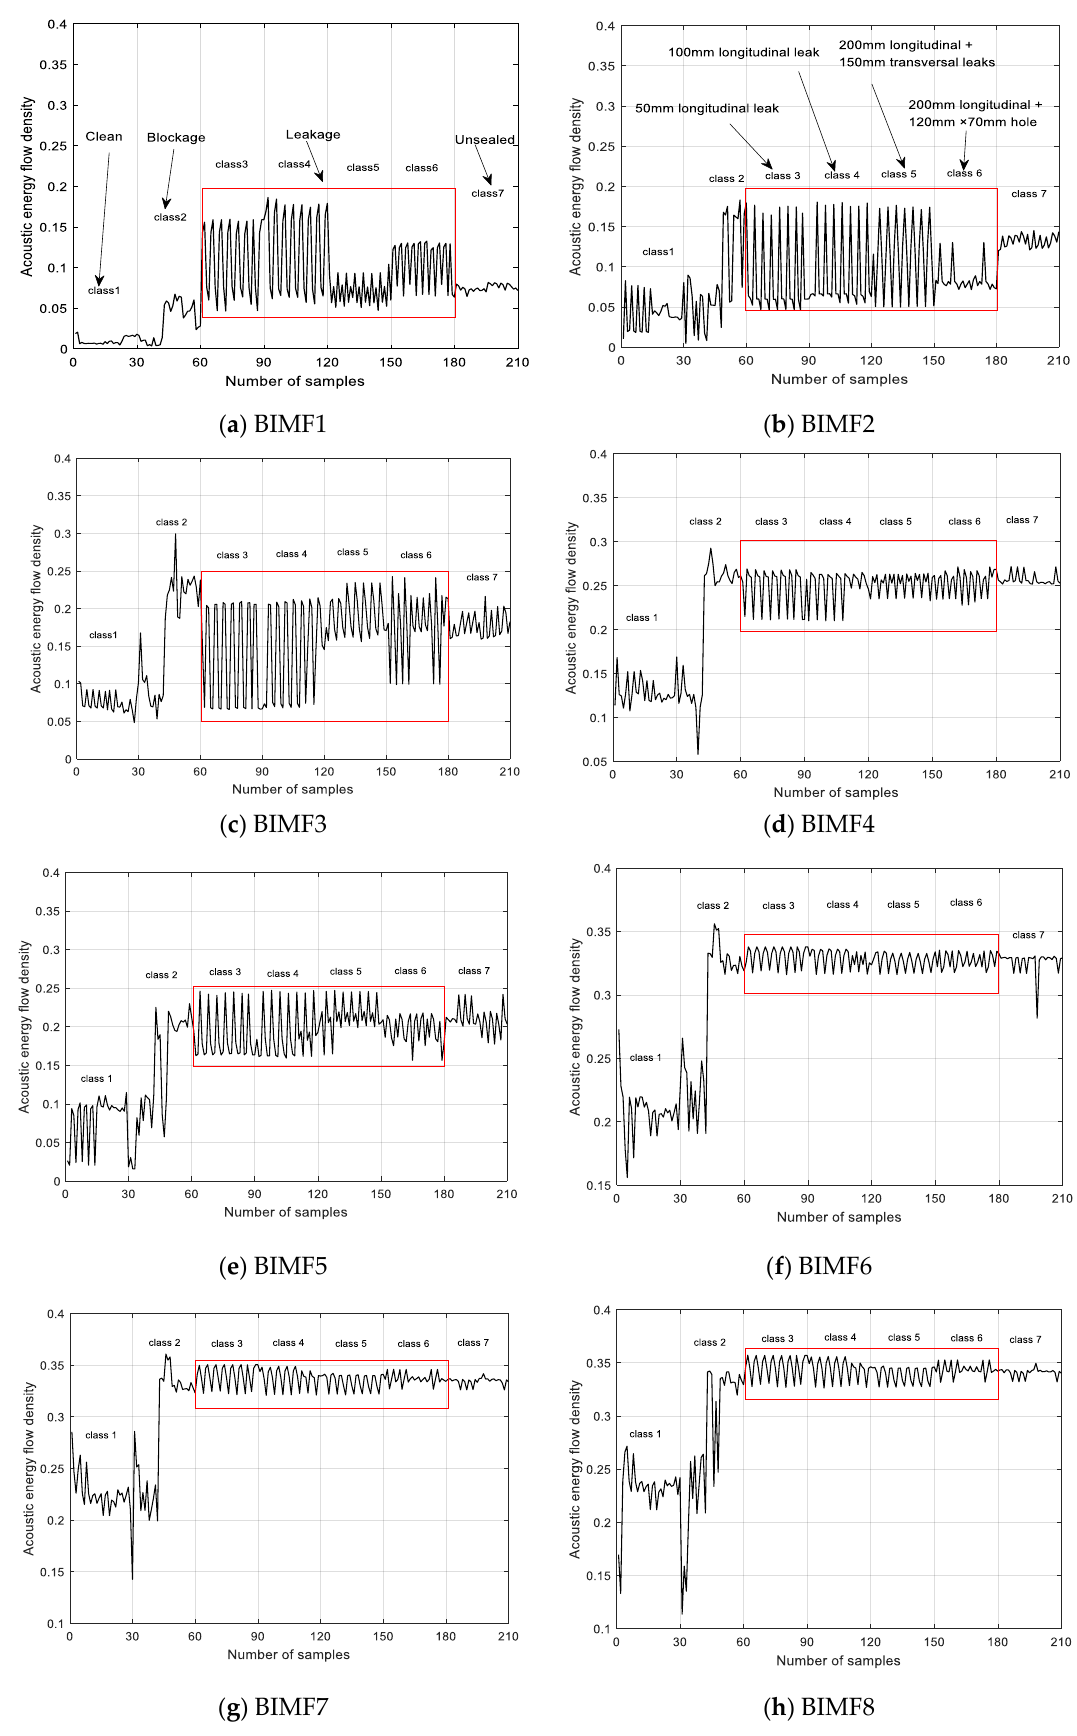
Figure 11. Eigenvectors of eight BIMF components in seven conditions of the siphon.